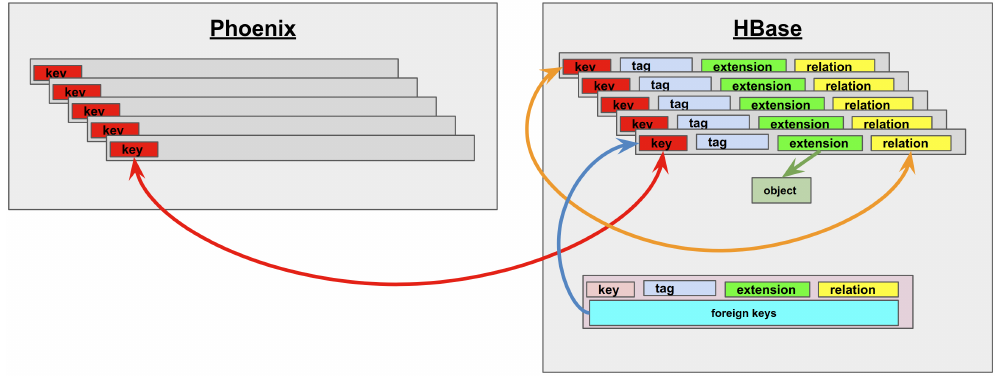
Figure 2. Schema of the Prototype 2